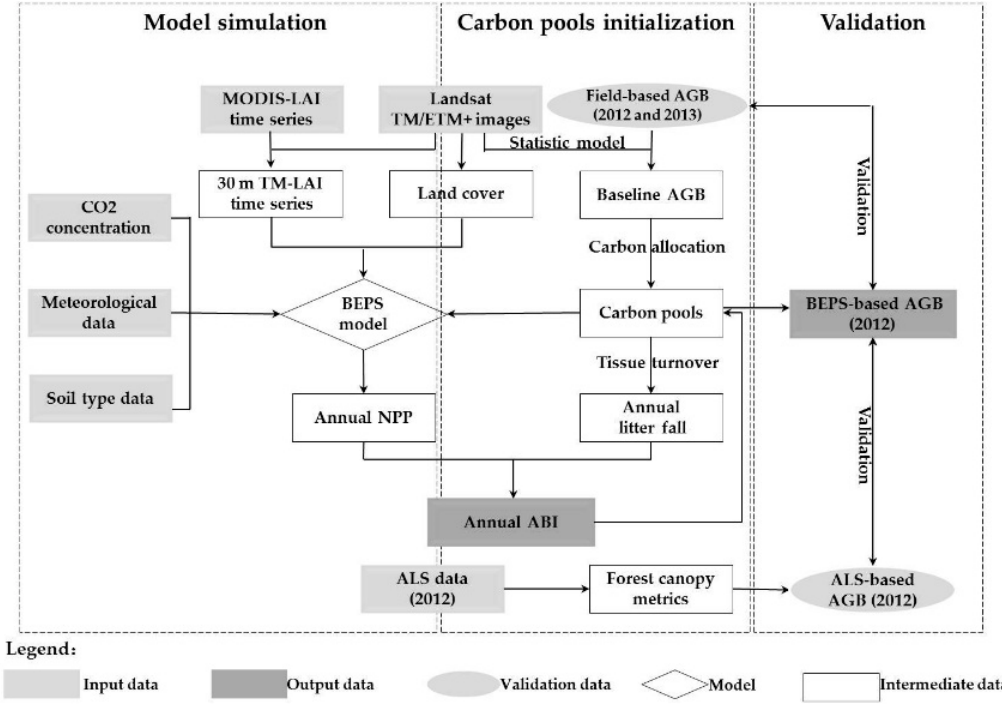
Figure 2. The flowchart of mapping and updating forest AGB by combining multi-source remotely sensed data and ecological process-based model. sensed data and ecological process-based